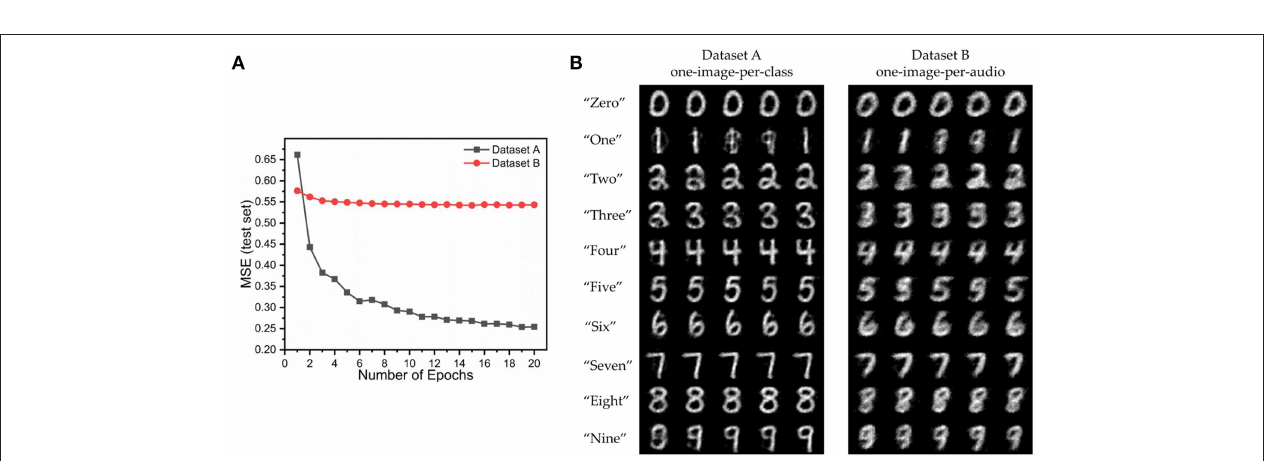
FIGURE 9 | The performance of the audio to image synthesis model on the two datasets - A and B [ T h = 10)] (A) Mean square error loss (test set) (B) Images synthesized from different test audio samples (5 per class) for the two datasets A and B.